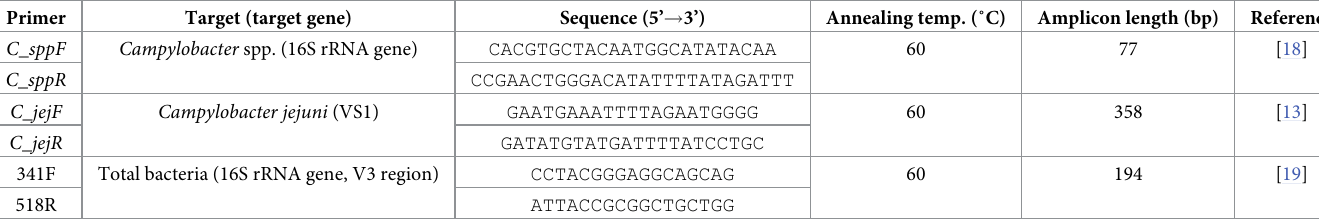
(Table 2), 1ng of DNA template and nuclease-free water (QIAGEN, Hilden, Germany). Cycling conditions (Mx3000thermocycler, Agilent Technologies) were 95˚C for 3 minutes fol- lowed by 40 cycles at 95˚C for 10 seconds and annealing and fluorescence detection at 60˚C for 20 seconds. Qualitative template control was performed through melting curve analysis, and all the reactions were run in triplicate, including a non-template control. Reaction effi- ciency based on standard curve analysis was evaluated through linear regression (r 2 ), slope and efficiency, whose values throughout the analyses performed were ~0.99, ~3.55 and ~95%, respectively, thus indicative of reliable technical performance. Table 2. List of primers used in this study.